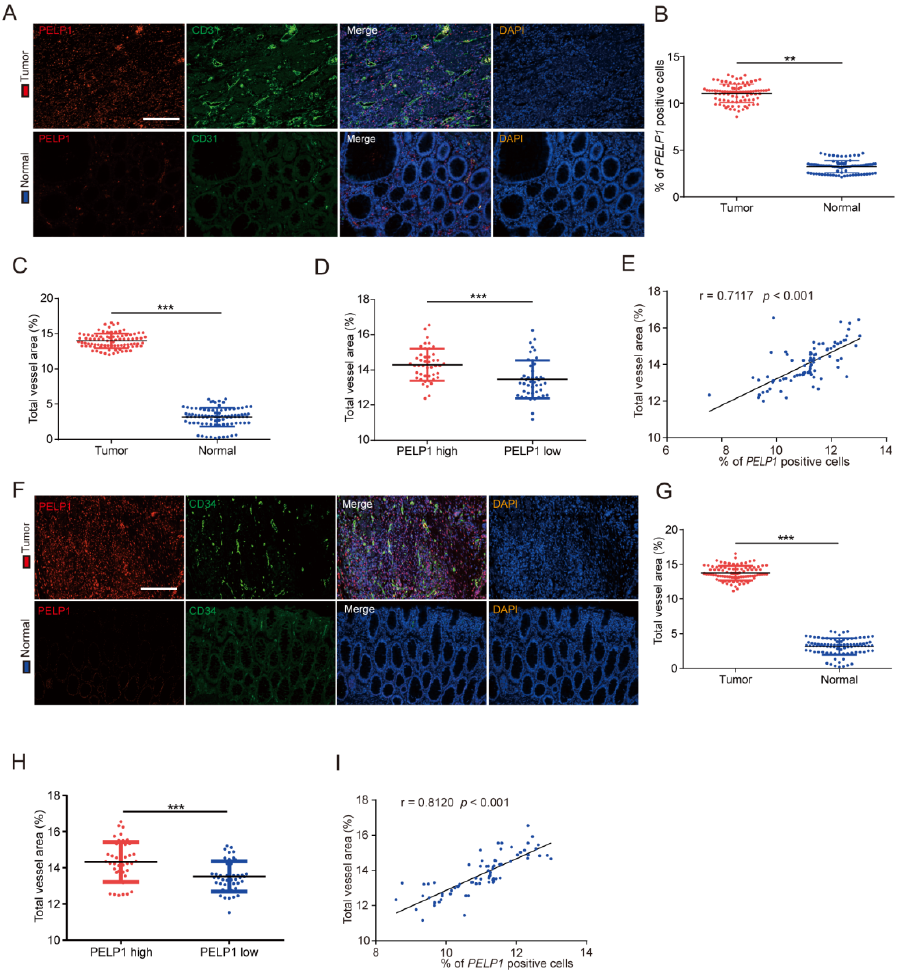
Figure 1. Correlation analysis between PELP1 and MVD in clinical CRC samples: ( A ) Representative images of immunofluorescence for PELP1 and CD31 in 90 CRC tissues and their paired normal tissues. Scale bar: 200 µ m. ( B ) Quantification of PELP1-positive cells in CRC tissues and paired normal tissues. ( C ) Quantification of MVD (CD31) in CRC tissues and paired normal tissues. ( D ) Quantification of MVD (CD31) in PELP1 low and PELP1 high CRC tissues. ( E ) Correlation analysis between PELP1 and MVD (CD31) in CRC tissues. ( F ) Representative images of immunofluorescence for PELP1 and CD34 in 90 CRC tissues and their paired normal tissues. Scale bar: 200 µ m. ( G ) Quantification of MVD (CD34) in PELP1 low and PELP1 high CRC tissues. ( H ) Quantification of MVD (CD34) in PELP1 low and PELP1 high CRC tissues. ( I ) Correlation analysis between PELP1 and MVD (CD34) in CRC tissues. Data are shown as the means of three independent experiments or representative data. Error bars indicate SD. ** p < 0.01, *** p < 0.001, by Student’s t